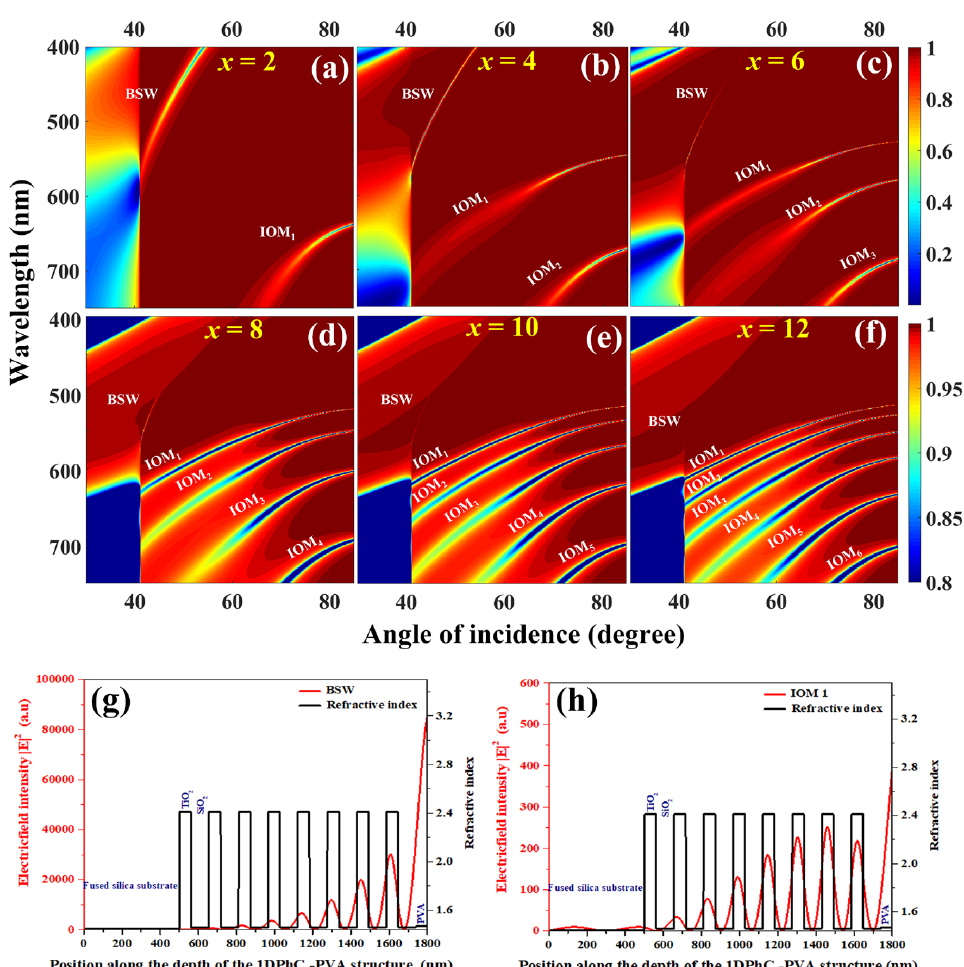
Figure 9. Dispersion diagrams for 1DPCx − PVA structures with ( a ) 2, ( b ) 4, ( c ) 6, ( d ) 8, ( e ) 10, and ( f ) 12 bilayers. The color bar represents the reflectance. The BSWs and IOMs are identified. ( g , h ) present the TE ‐ polarized electric field intensity profiles for BSW and IOM supported by the 1DPC8 ‐ PVA structure. The corresponding refractive index profile of the 1DPC8 ‐ PVA structure is also shown. Adapted with permission from [56].